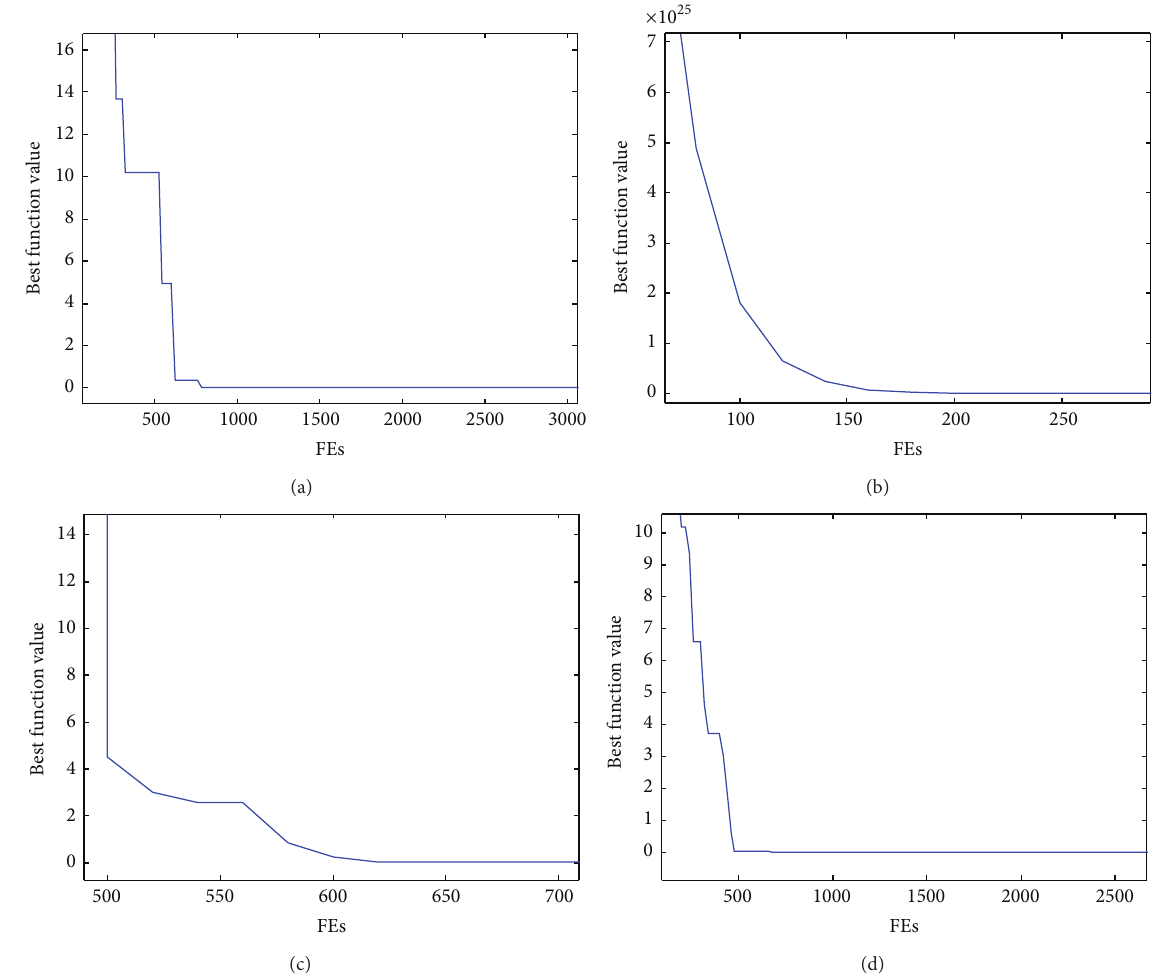
Figure 2: The evolutionary process of PSO-VRS on test functions, (a) Rosenbrock function, (b) variably dimensioned function, (c) Wood function, and (d) Ackley